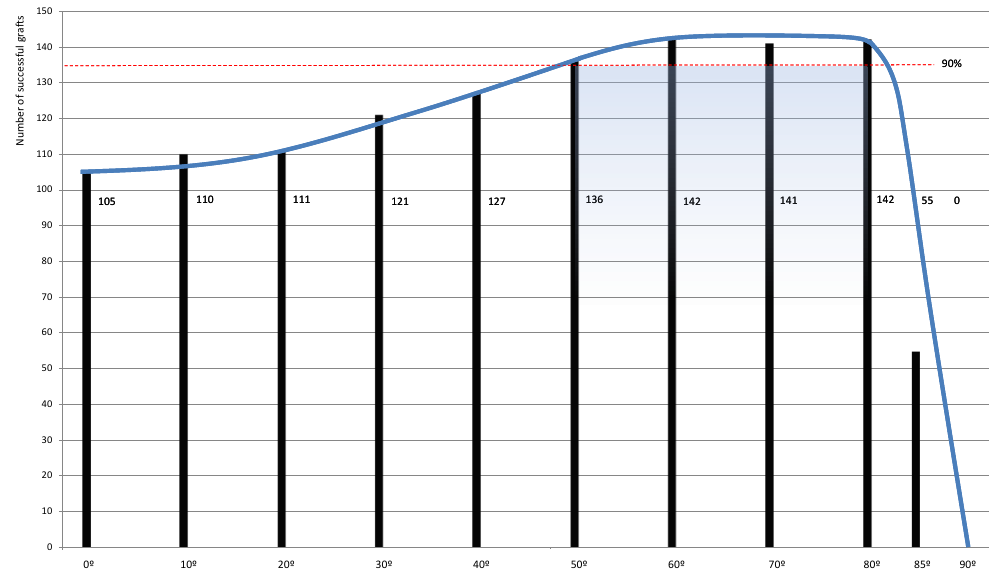
Figure 4. Distribution of successful grafts according to different cutting angles. It can be seen that the zone between 50° and 80° (blue zone), has a success rate higher than 90%, so we can consider it an optimal work zone. This graph represents the absolute number of successes for each cutting angle, without considering the variable of difference between diameters.